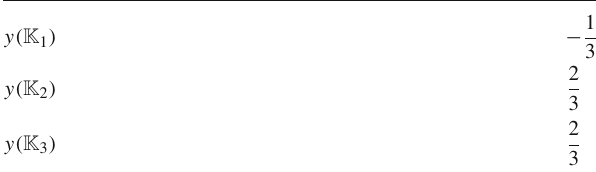
Table4 Anexampleofvaluesofthehyperchargesfortheexoticquarks K i using condition (38). As discussed in Eq. (5), y These values are independent of the solutions for z ( F ) , with F denoting the exotic